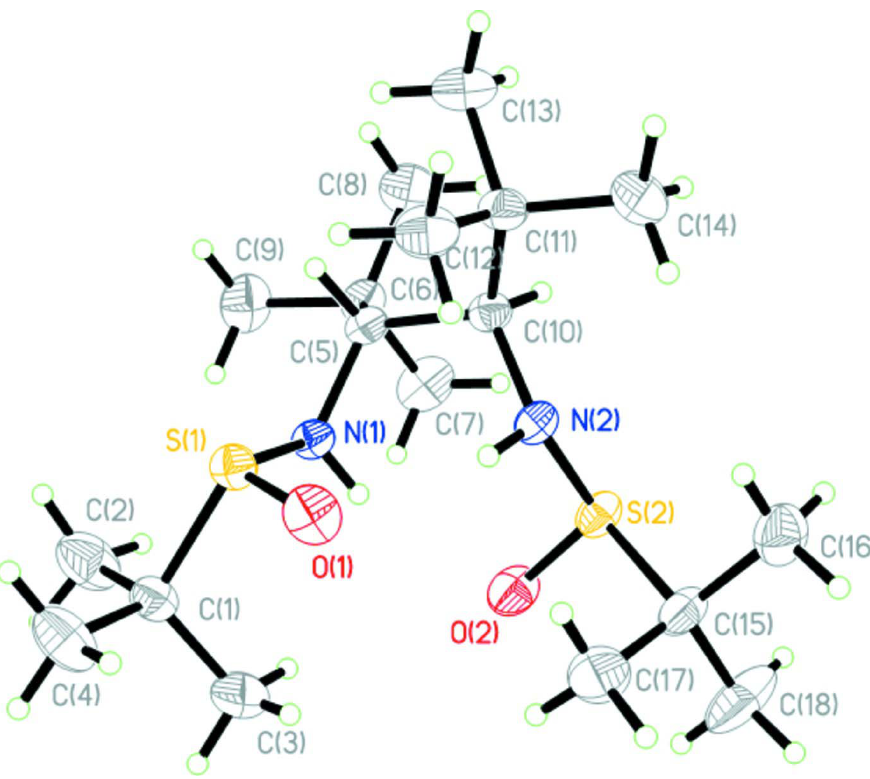
Figure 1 Molecular structure of title compound in the solid state, showing the labeling scheme. The crystallographic 2-fold axis passes through the C5-C10 bond and is perpendicular to the plane of the picture.